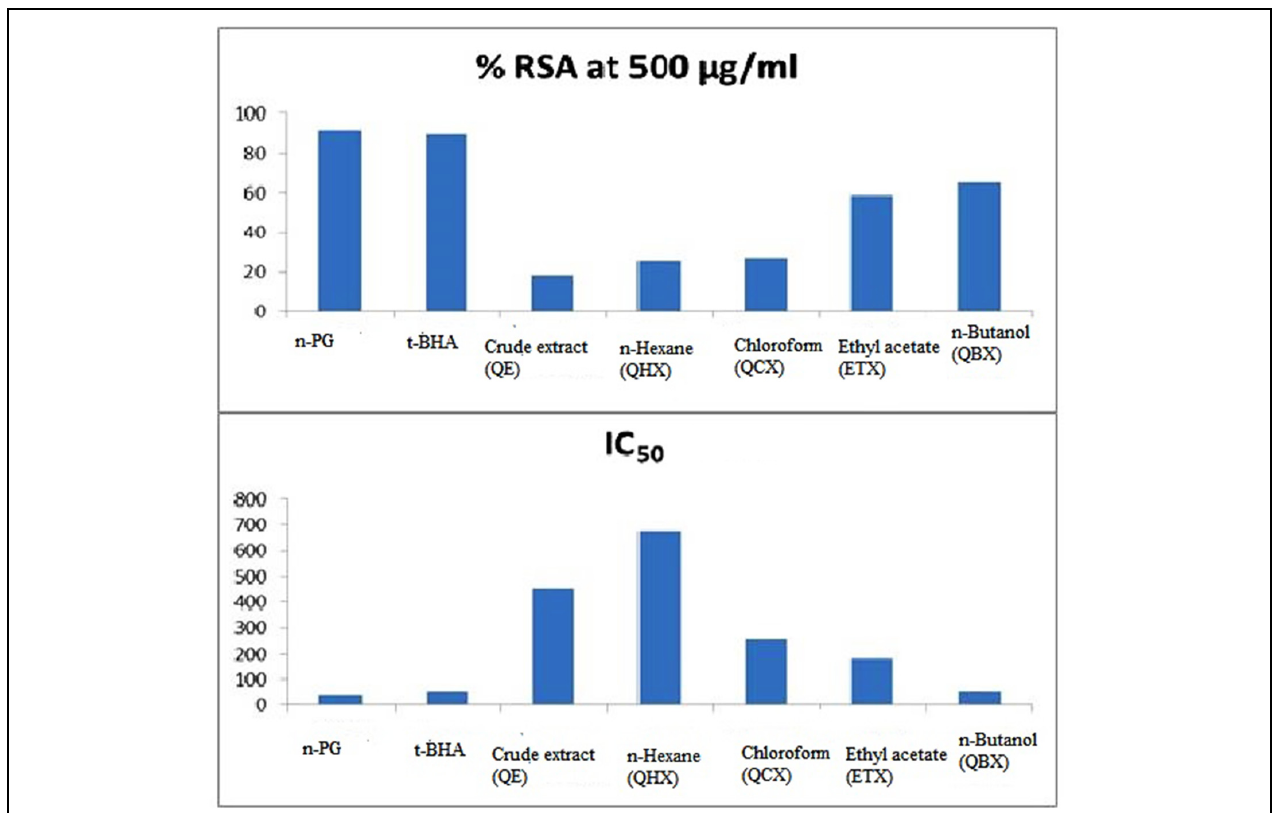
FIGURE 1 | Antioxidant activity in % RSA and IC 50